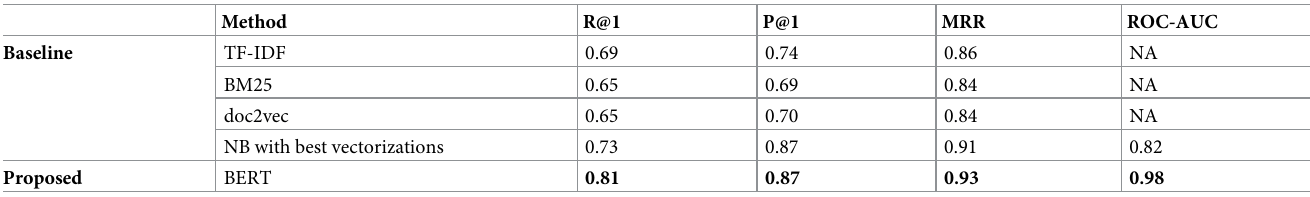
Table 6. Test results for baselines vs. our proposed method.